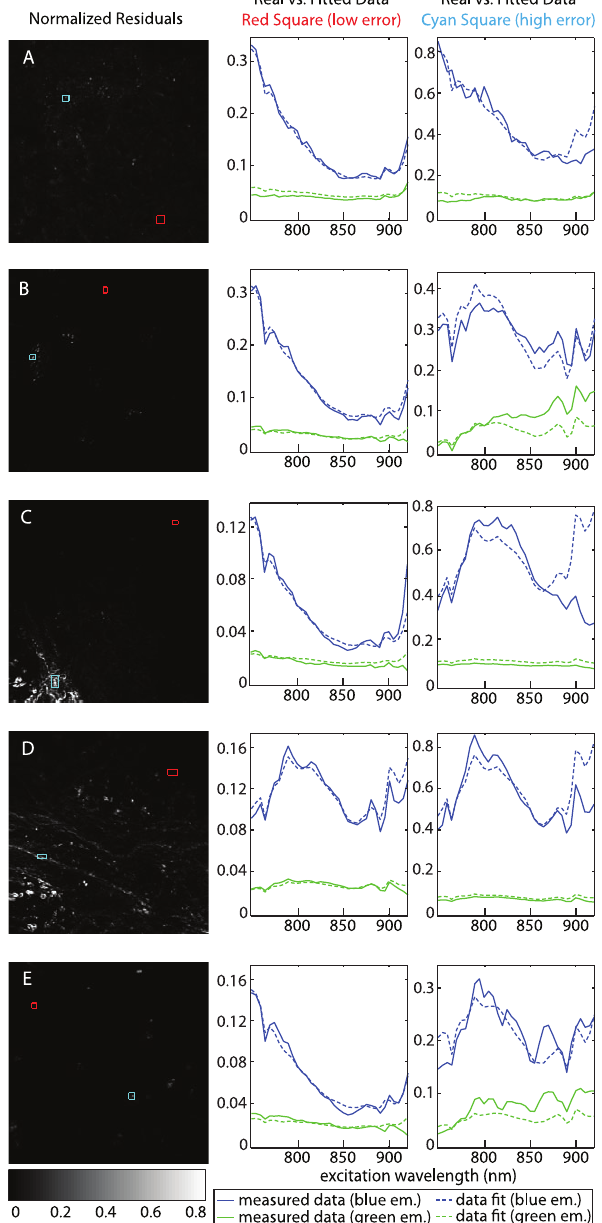
Figure 5. Residuals for the non-negative least squares fits of hyperspectral data that correspond to analysis shown in Figure 4. Images (left column) show the square of the Euclidean norm of the residuals from all excitation wavelengths. Plots (right) compare the measured spectra to the fitted data in selected areas of the images for a well matched region (red box) and a region with relatively high error (cyan box). (A) Glandular level in the colon. (B) Villi in the small intestine. (C) Glandular level of the small intestine. (D) Peyer’s patch in the small intestine. (E) Lesion from the small intestine of an APC min / + mouse.